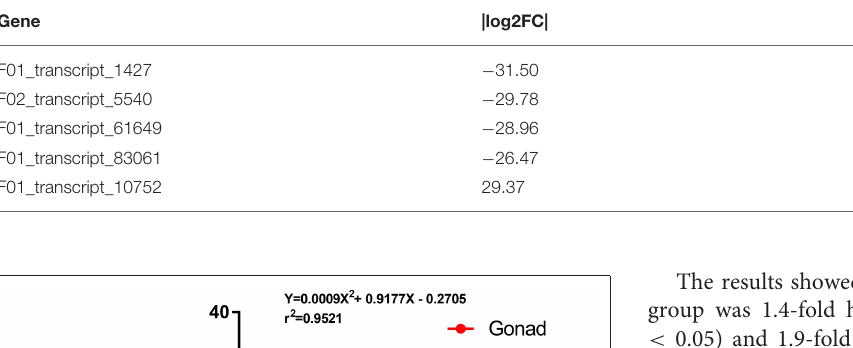
TABLE 4 | Specifically expressed genes of the top five |log2FC| in gonad.